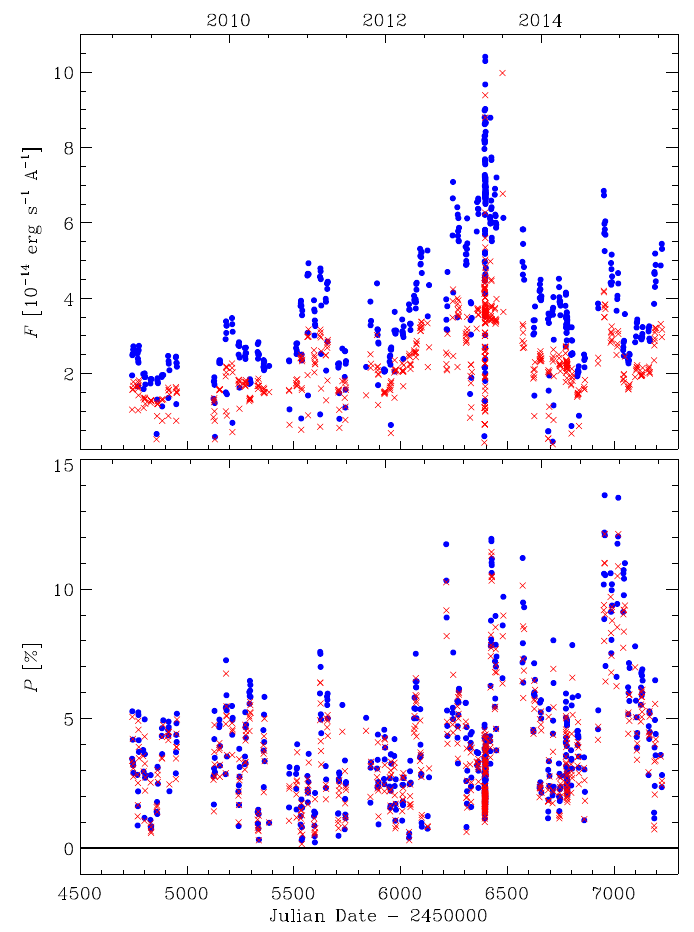
Figure 6. Time evolution of the observed flux density ( top ) and degree of polarization ( bottom ) in two different wavelength ranges (blue and